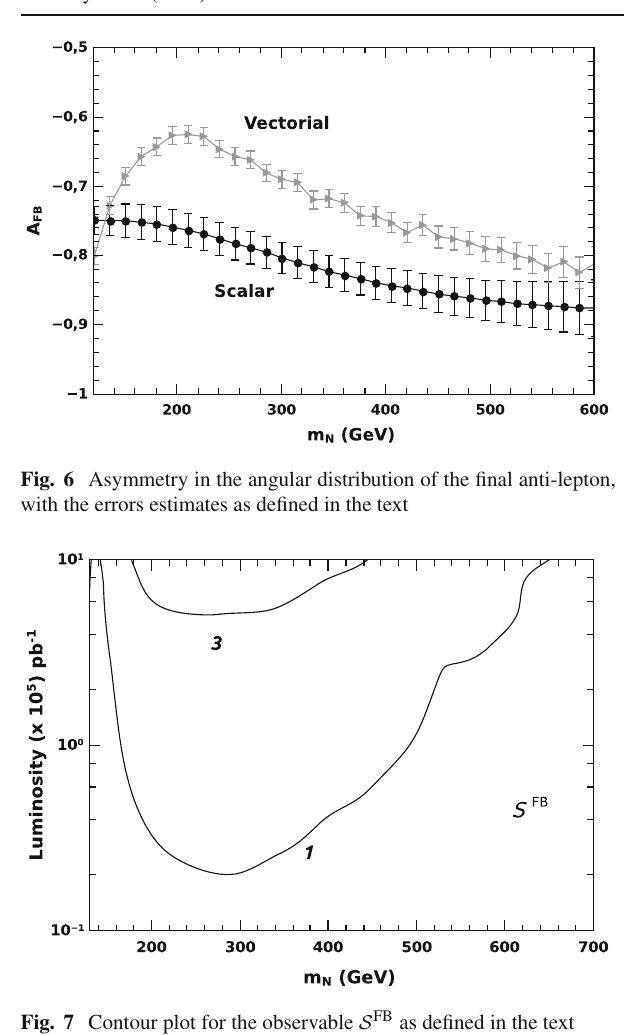
Fig. 7 Contour plot for the observable S FB as defined in the text